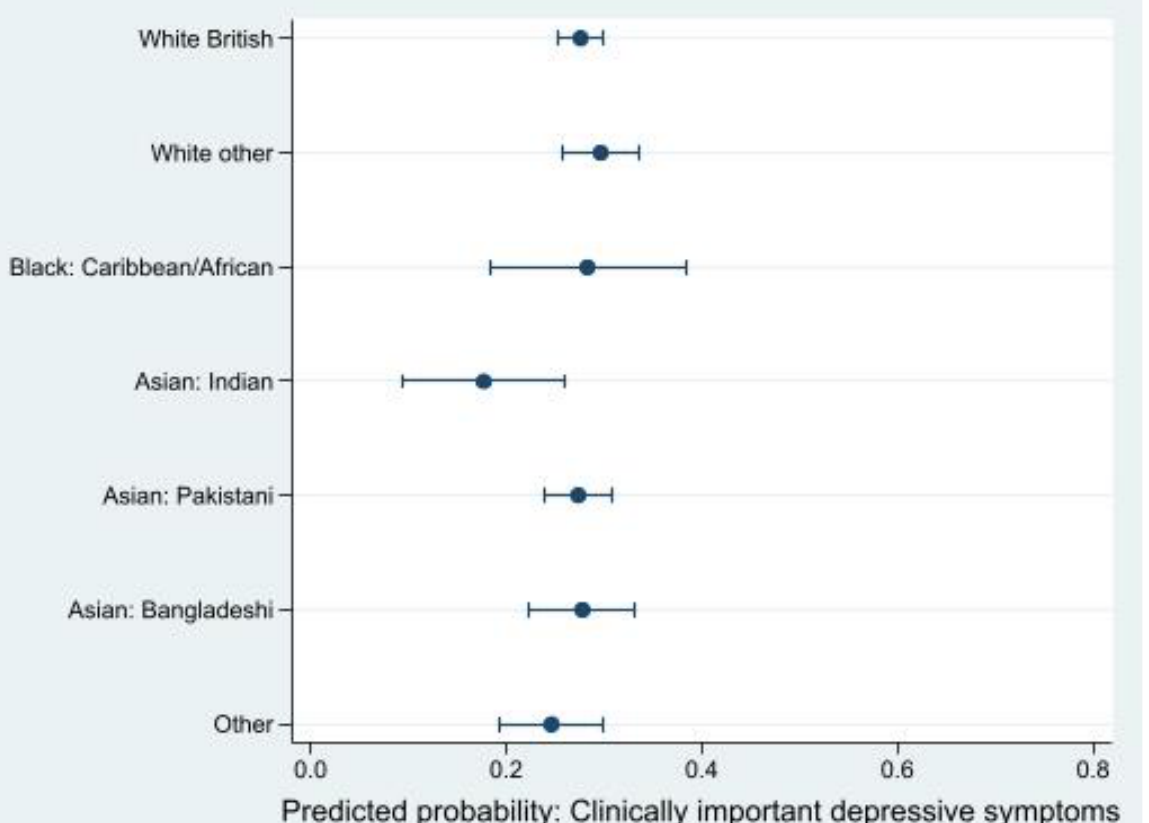
Figure 4. Predictive probability of clinically important depressive symptoms by ethnicity ( n = 2807). Regression model for the association between ethnicity and depressive symptoms was adjusted for location of residency (Bradford (ref), London) with interaction terms between ethnicity and financial insecurity (secure (ref), insecure), ethnicity and loneliness (none of the time (ref), some of the time, most of the time), ethnicity and social support (high (ref), medium, low levels).